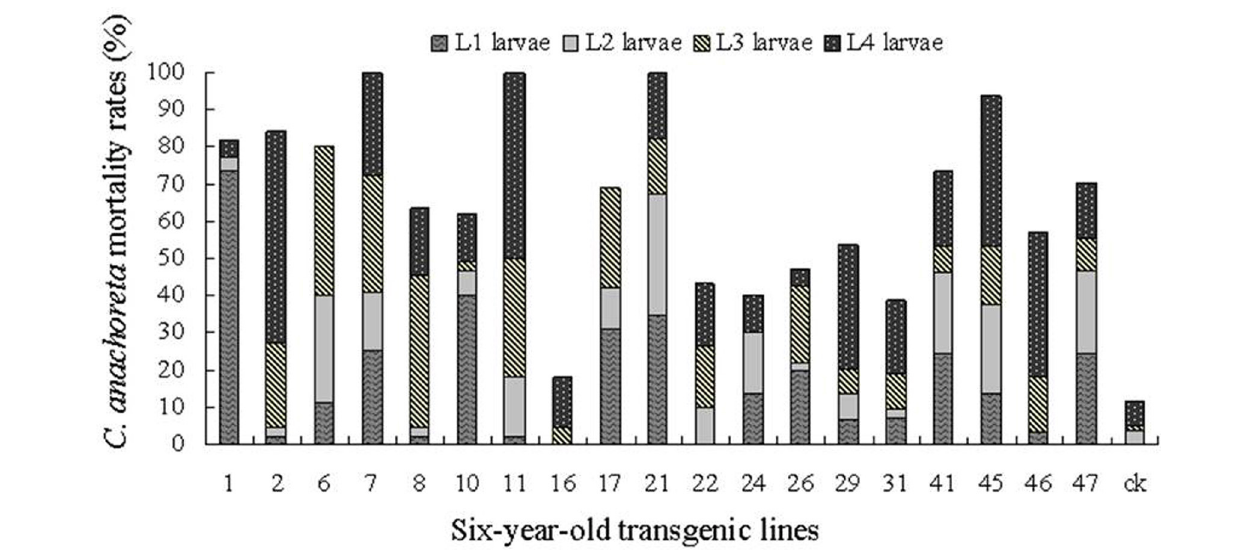
FIGURE 7 | C. anachoreta death distribution in different developmental stages of 6-year-old trees. Data are means of three replicates. This mortality is not corrected mortality. Larval death was observed at different stages of 6-year-old trees. The proportion of larvae that died in the L 3 and L 4 stages increased.